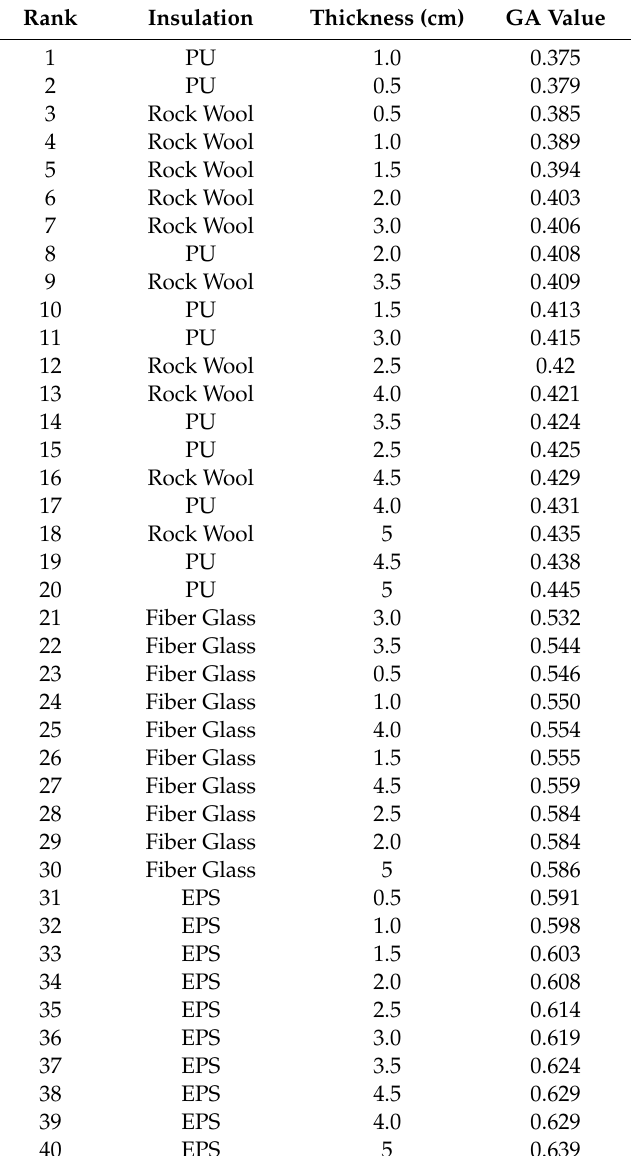
Table 5. Ranking of the optimal configuration of the insulations.